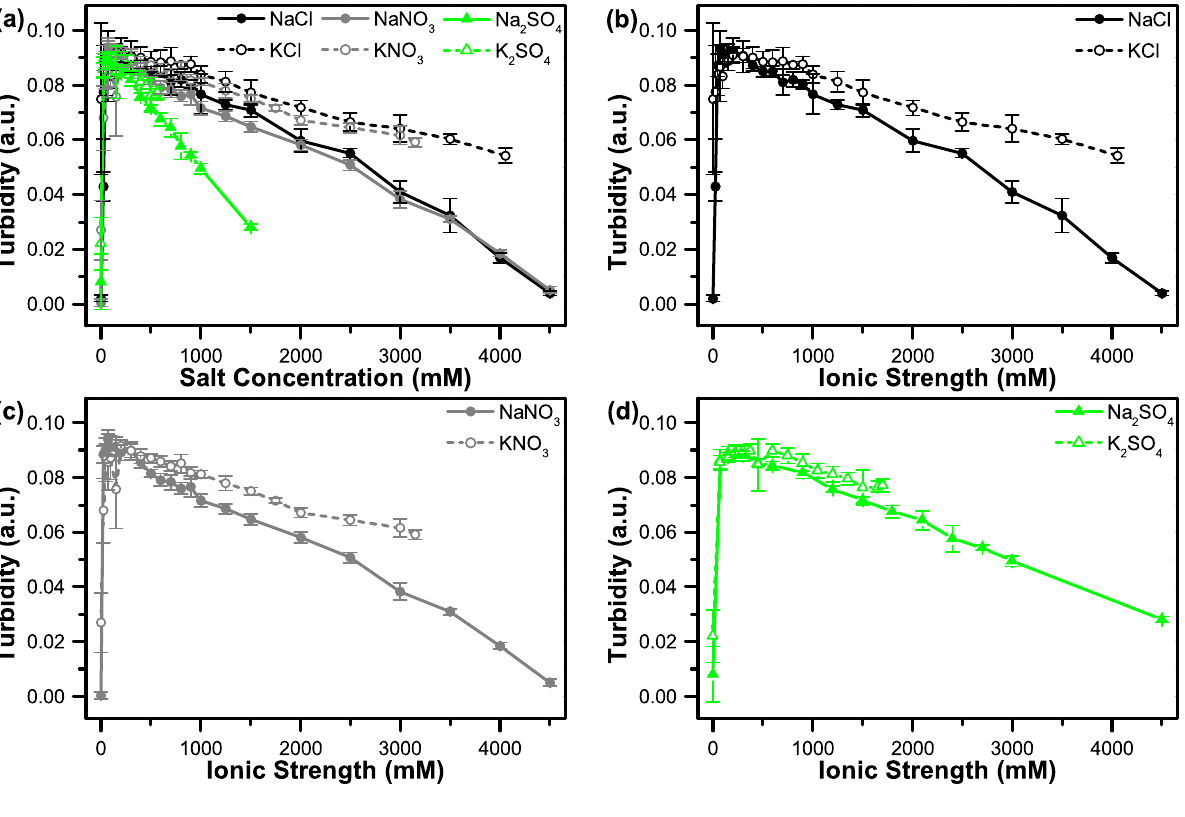
Figure 7. ( a ) A plot of turbidity as a function of salt concentration, showing a comparison of different pairs of sodium and potassium salts, which are highlighted individually in ( b – d ) as a function of ionic strength for ( b ) NaCl/KCl, ( c ) NaNO ( d ) Na SO /K SO . All samples were prepared at 1 mM total monomer concentration, 2 4 2 4 50/50 mol% pAA/pAH ratio at pH 6.5. Complexes were prepared by adding pAA to a solution containing a mixture of pAH and the desired quantity of